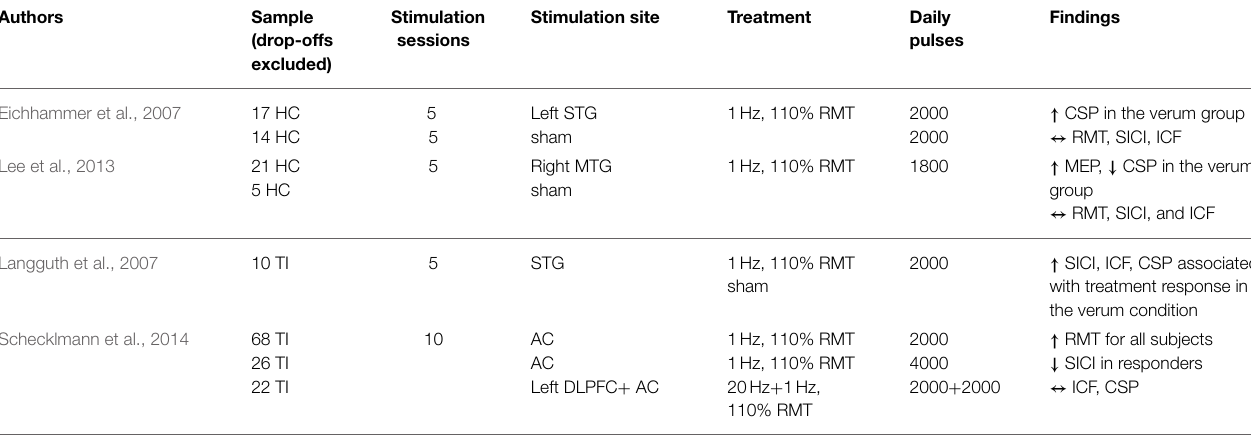
TABLE 2B | Overview of study parameters of temporal cortex rTMS studies investigating motor cortex excitability.